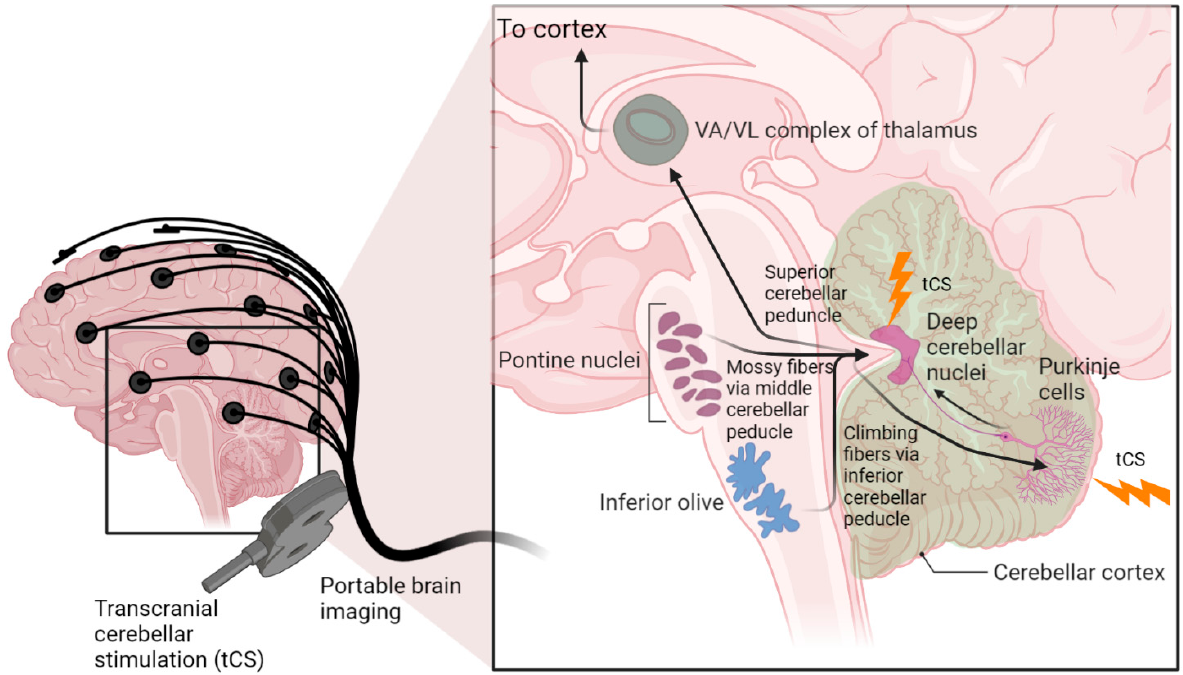
Figure 1. Cerebellocortical circuit. The cerebellum sends its output through the superior cerebellar peduncle, the contralateral red nucleus, and ventral anterior/ventral lateral nucleus of the thalamus to various cerebral areas, including the motor cortex, the prefrontal cortex, the parietal cortex, and the temporal cortex. Recent work has found that the frontoparietal network is disproportionately expanded in the cerebellum compared to the cortex. Transcranial cerebellar stimulation can affect the integration of sensory and cortical signals at the cerebellar cortex (Purkinje cells) as well as the deep cerebellar nuclei through which the cerebellum delivers its output to the cerebral cortex. (created using BioRender.com).